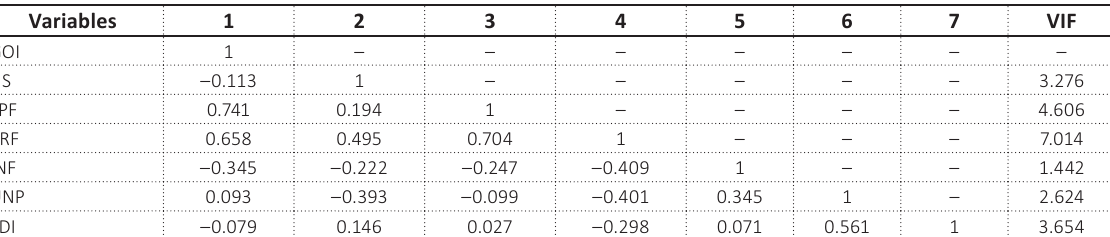
Table 3. Correlation and VIF results of Asian countries